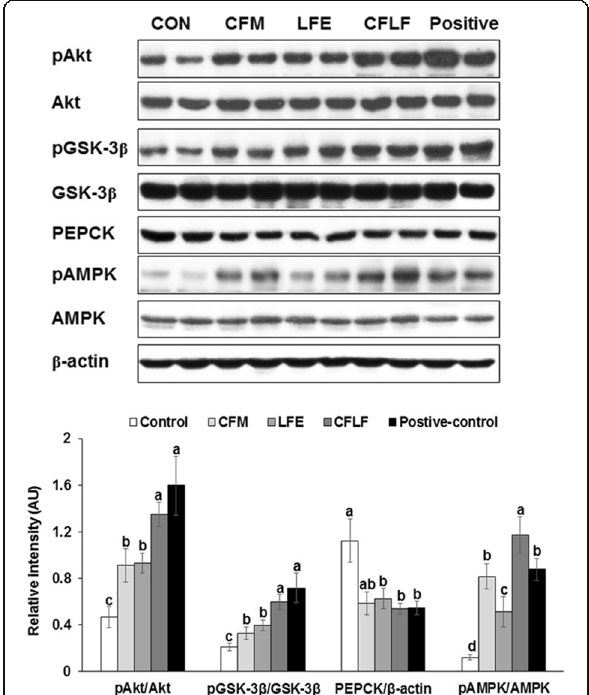
Fig. 4 Hepatic insulin signaling. Control, OVX rats fed a high-fat diet (HFD) with 1% dextrin; CFM, OVX rats fed an HFD with 1% lyophilized cauliflower mushroom; LFE, OVX rats fed an HFD with 0.1% L . fermentum plus 1% dextrin; CFLF, OVX rats fed an HFD with 1% CFM plus 0.1% L . fermentum ; positive-control, OVX rats fed an HFD with 1% dextrin plus 30 μ g/kg body weight 17 β -estradiol. Hepatic insulin signaling was determined by immunoblotting assays. Each bar represents the mean ± SD ( n = 4). Different letters represent a significant difference in Tukey test at p < 0.05